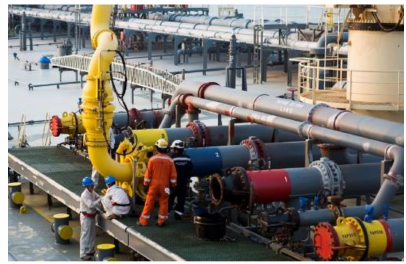
Figure 3. An actual manipulator arm docking